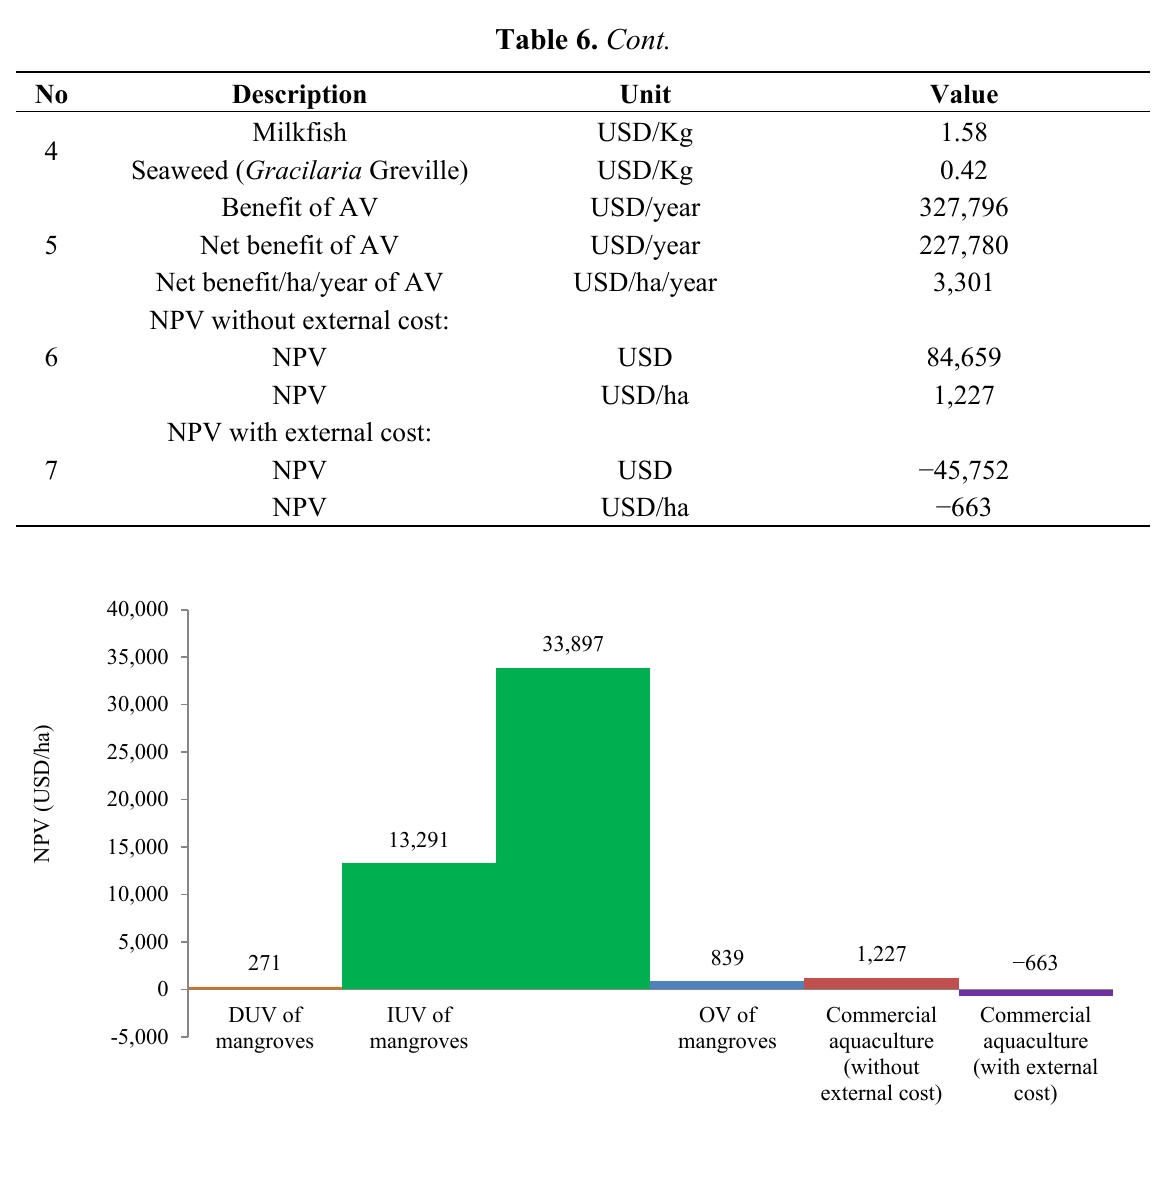
Figure 2. Comparison of the Net Present Value (NPV) of mangrove versus commercial aquaculture in the Takalar district, South Sulwesi,